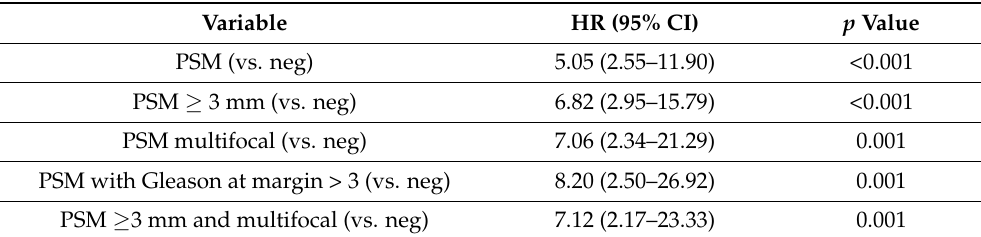
Table 4. Cox regression model predicting biochemical recurrence after RARP and the role of PSM characteristics in patients with favourable pathology after RARP (pT2 and ISUP <